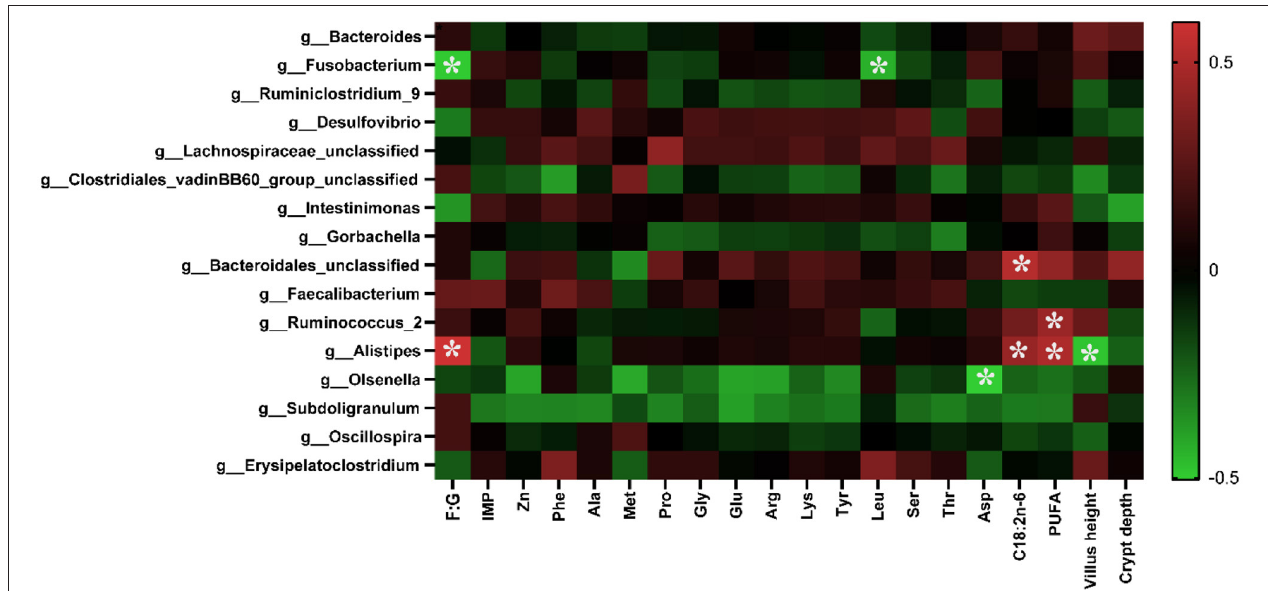
FIGURE 4 | Correlation analysis of environmental factors. The colors range from green (negative correlation) to red (positive correlation). The data were analyzed using Pearson’s correlation coefficient. *In green grid indicates a negative correlation ( p < 0.05), whereas in the red grid represents a positive correlation ( p < 0.05).